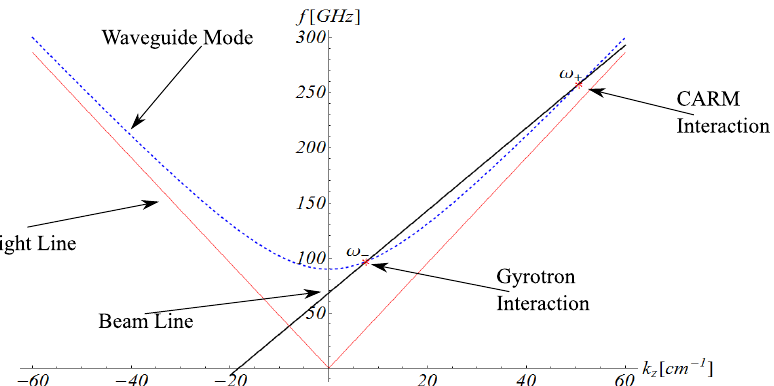
Figure 7. Brillouin diagram for the different conditions of electron cyclotron resonance selections corresponding to the intersections of the beam line (straight line) with the dispersion curve of the operating cavity mode (dotted